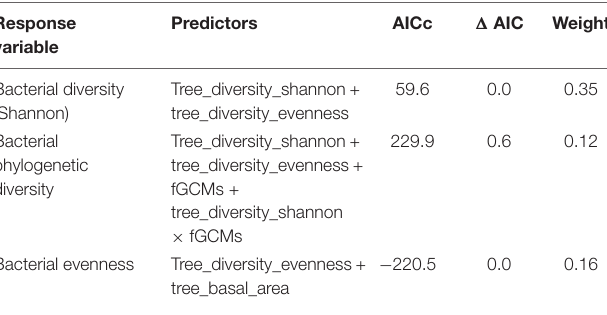
TABLE 4 | Best model based on AICc, (cid:49) AIC, and model weight for each alpha bacterial diversity of black howler monkeys ( Alouatta pigra ) inhabiting forest fragments at Escárcega, State of Campeche,